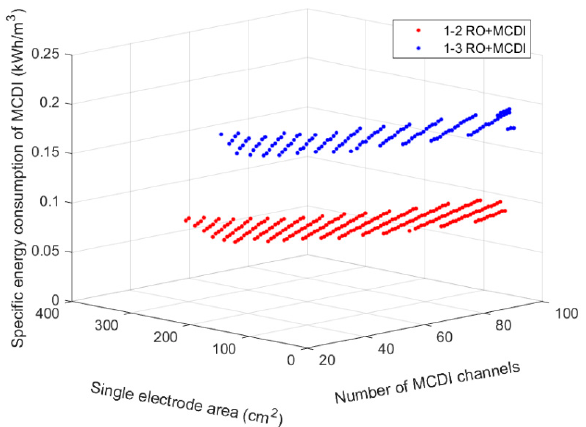
Figure 9. Relationship among number of channels, area of single electrode and specific energy consumption of MCDI.